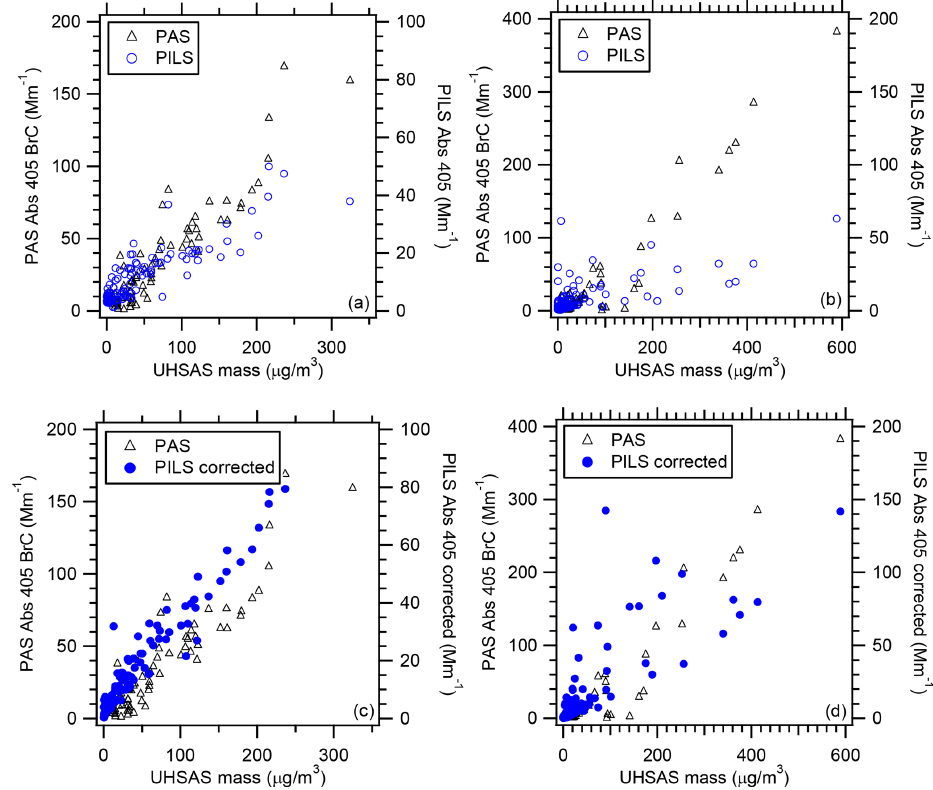
Figure 4. Correlation of PAS total Abs 405 BrC and PILS water-soluble Abs 405 vs. UHSAS mass for WE-CAN (a) flight RF02 and (b) flight RF11. Correlation of PAS total Abs 405 BrC and PILS water-soluble Abs 405 corrected for the non-water-soluble fraction of the aerosol using the UHSAS mass for WE-CAN (c) flight RF02 and (d) flight RF11. In plot (a) , the equations for the fit and R 2 value for PAS are y = (0 . 50 ± 0 . 02) x − (0 . 03 ± 2 . 29) and R 2 = 0 . 87 and for PILS are y = (0 . 14 ± 0 . 01) x + (5 . 58 ± 0 . 65) and R 2 = 0 . 75, respectively. In plot (b) , the equations for the fit and R 2 value for PAS are y = (0 . 62 ± 0 . 03) x − (6 . 09 ± 3 . 62) and R 2 = 0 . 76 and for PILS are y = (0 . 08 ± 0 . 01) x + (3 . 58 ± 0 . 66) and R 2 = 0 . 43, respectively. In plot (c) , the equation for the fit and R 2 value for PILS are y = (0 . 32 ± 0 . 01) x + (3 . 60 ± 0 . 68) and R 2 = 0 . 94, respectively. In plot (d) , the equation for the fit and R 2 value for PILS are y = (0 . 24 ± 0 . 01) x + (2 . 93 ± 1 . 35) and R 2 = 0 . 65, respectively. Uncertainties with the least square regressions are 1 standard